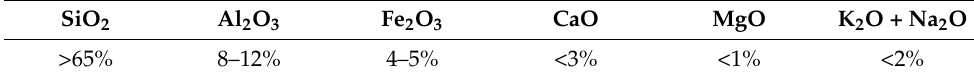
Table 1. Percentage limits of the oxides of the searched raw materials.